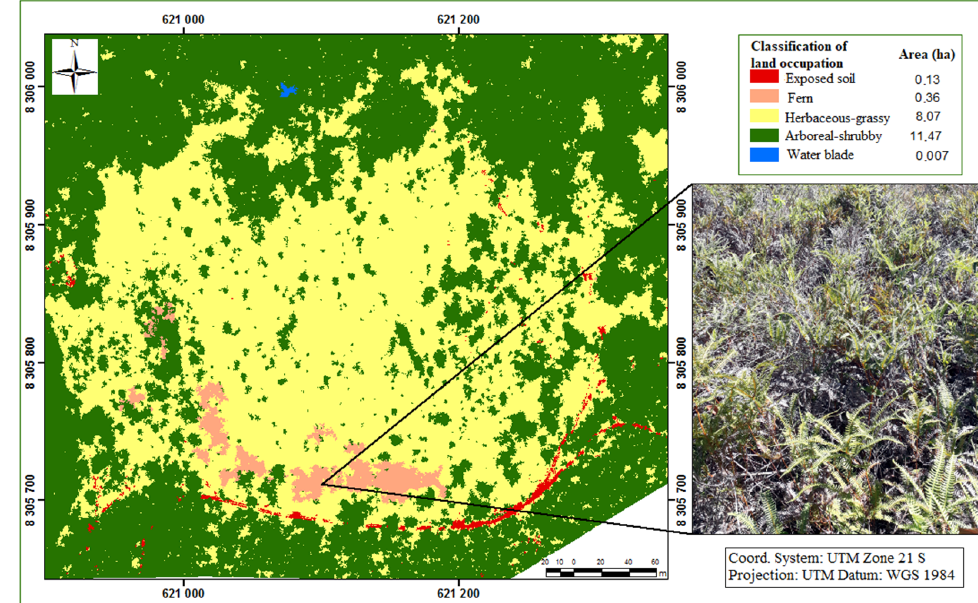
Figure 4. OBIA classification of the orthomosaic image of 23 May 2018—‘pre–burn’.